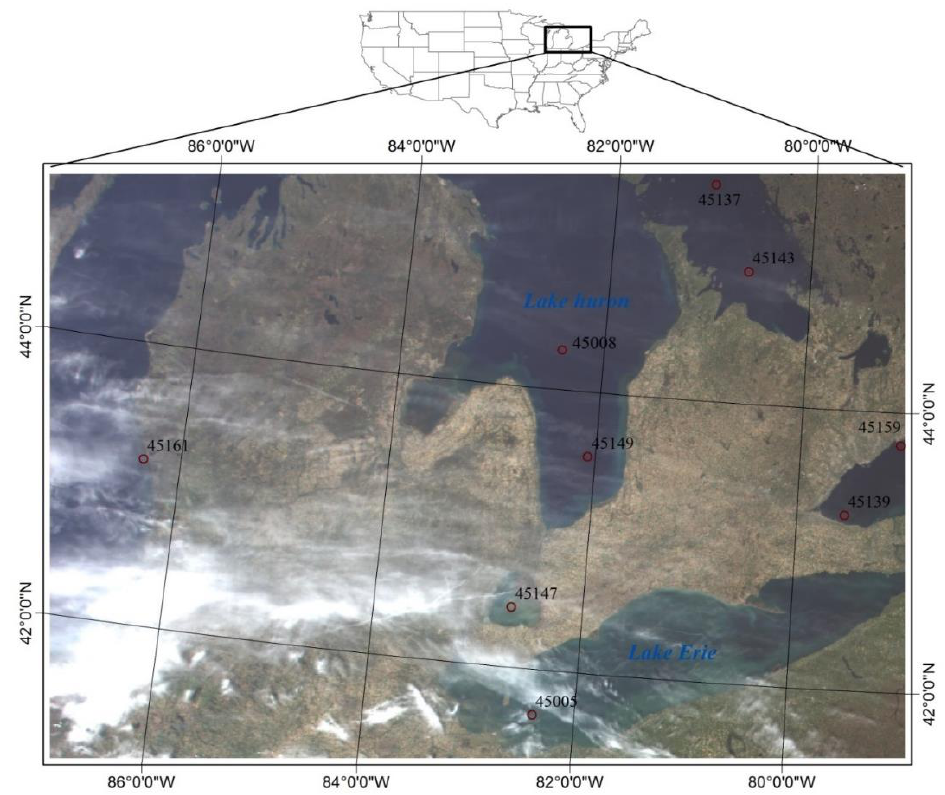
Figure 1. MODIS/Terra true color map of the study area around the Great Lakes on 6 May 2013 (MOD021KM.A2013126.1605.006.2013127012129) indicating the locations of the nine buoys selected in this